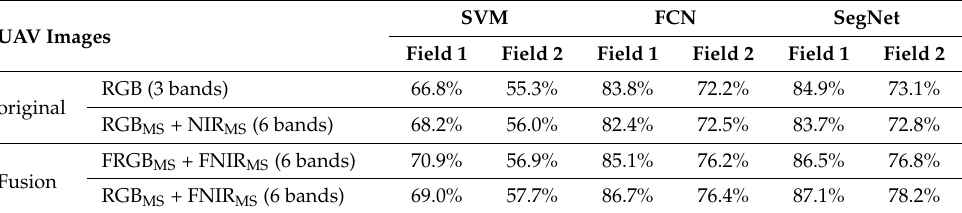
Table 7. Comparison of machine learning, deep learning and image fusion performances.